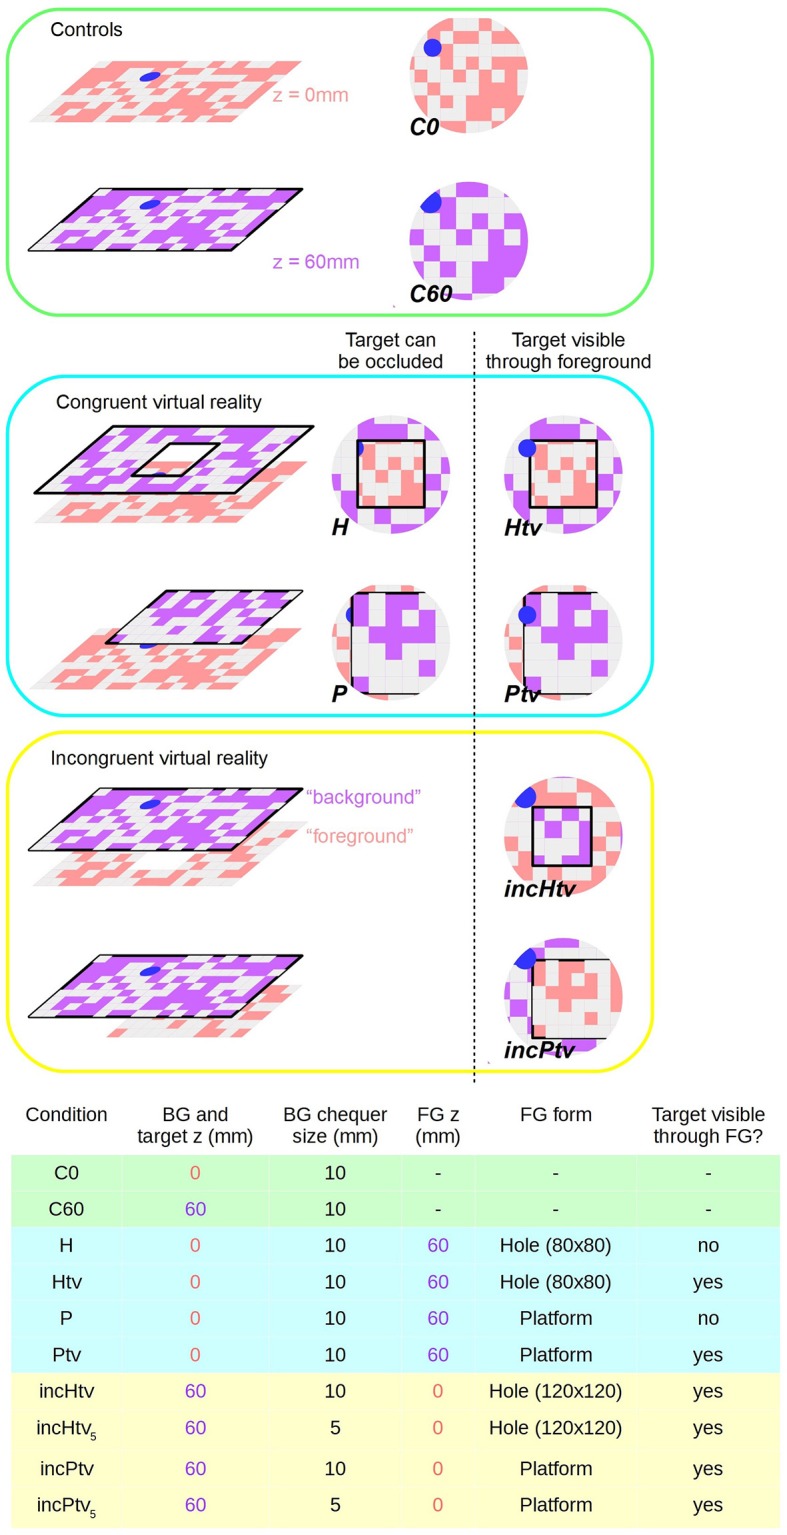
Virtual reality conditions. Left: schematic diagram showing surfaces at virtual altitudes of 0 mm (i.e., static, pink) and 60 mm (closed-loop, purple). Right: representation of bee's ventral visual field; the center of the circle is the nadir. Pink and purple coloring is to denote z-depth only; actual chequerboard patterns are all pink/white. Chequerboard texture is not to scale. Bottom: Table summarizing the parameters that differ between conditions. BG stands for background; FG for foreground. Shading indicates which group (control, congruent VR, incongruent VR) each condition belongs to. Conditions incHtv5 and incPtv5 are not shown, but are simply incHtv and incPtv respectively with the spatial frequency of the background (purple) texture doubled.